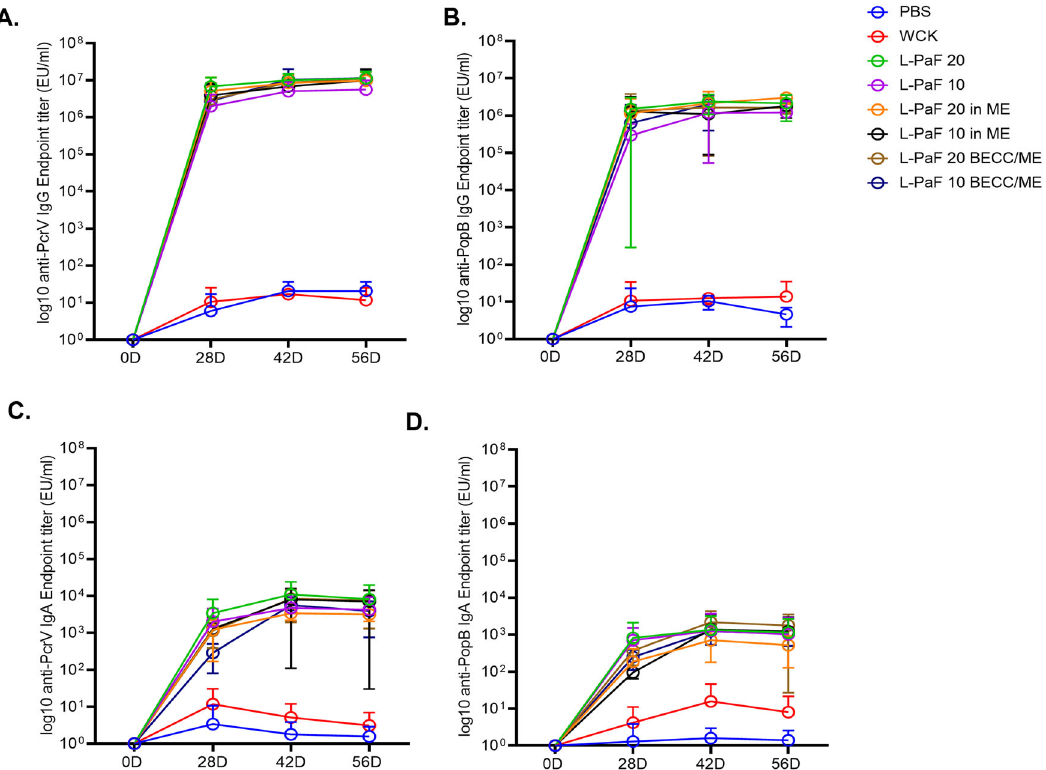
Fig. 1 Kinetics of serum IgG and IgA. CD-1 mice were vaccinated on days 0, 14 and 28 and their sera were assessed for anti-PcrV and anti- PopB immunoglobulins as a function of time and boosting. Anti-PcrV IgG ( A ) and IgA ( C ), along with anti-PopB IgG ( B ) and IgA ( D ), are shown. Individual titers are represented as EU/ml. Each point denotes a mean and error bars represent SD for each group ( n = 10 mice/group).